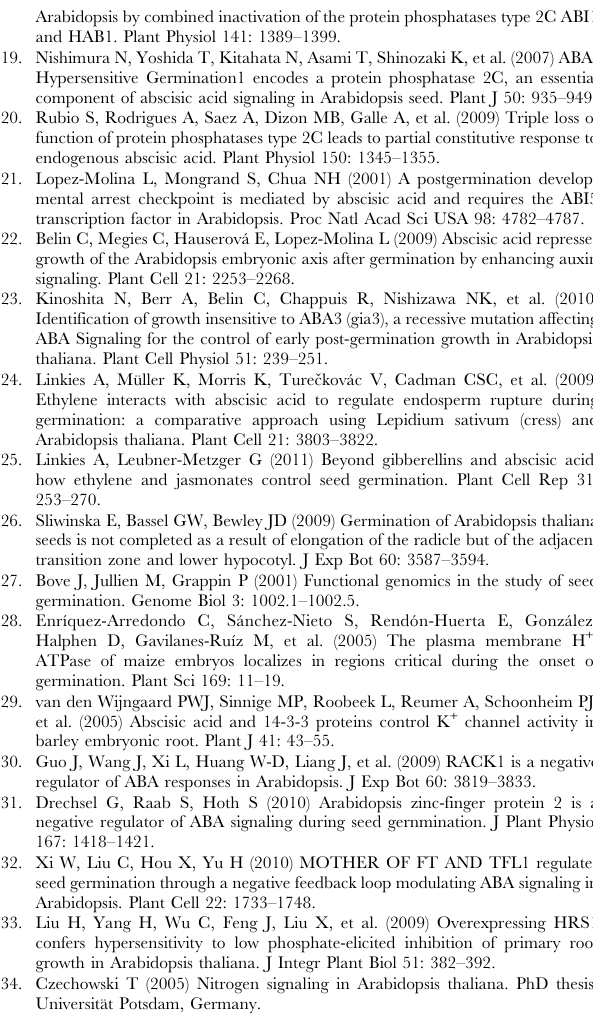
Table S1 Oligonucleotide primers used in this